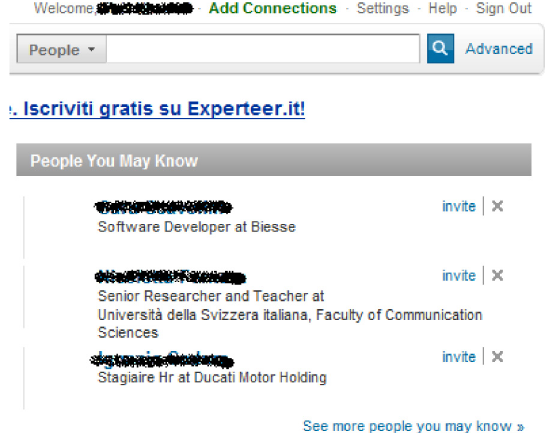
Figure 6. An example of latent ties suggested in People You May Know on LinkedIn (image taken from the original on